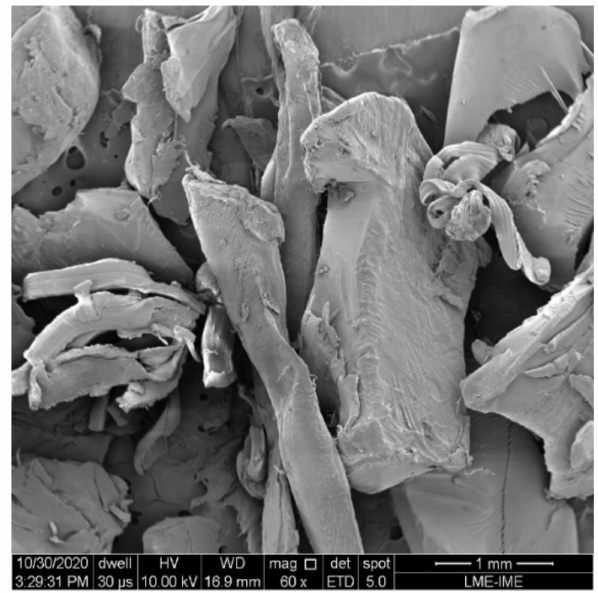
Figure 5. Scanning Electron Microscopy (SEM) of PET 60 × magnification.